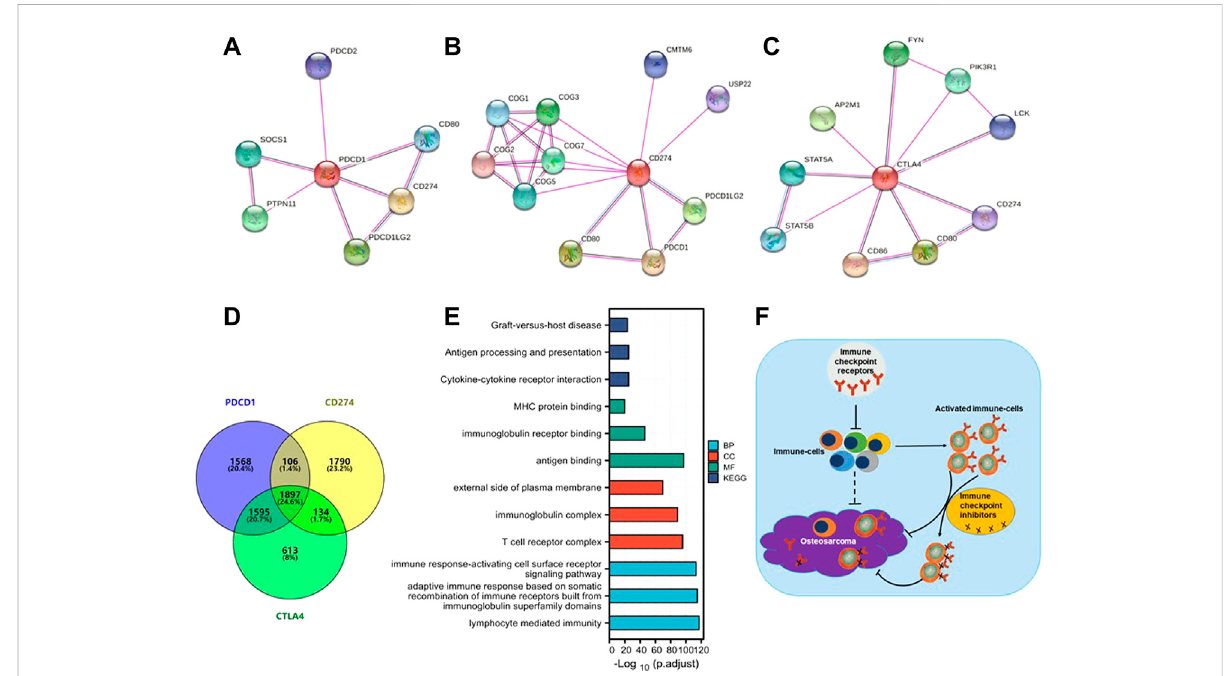
FIGURE 8 PD-1/PD-L1/CTLA-4 relatedgeneenrichmentanalysis. (A,B,C) The top10hubgenesinthePPI(Protein- ProteinInteraction)networkwithhigh con fi dence using STRING tool. Circles represent different genes in the three modules, and interconnecting lines represent interactions between these genes. PD-1 (A) , PD-L1 (B) and CTLA-4 (C) are high-con fi dence hub genes for each other (circle logo). (D) Venn diagram showed that PD-1/ PD-L1/CTLA-4 cross-co-expressed 1897 genes in SARC, accounting for the largest proportion of 24.6%. (E) Based on PD-1/PD-L1/CTLA- 4 cross-co-expressed genes, GO-KEGG pathway enrichment analysis revealed co-expressed pathways. Gene Ontology (GO); Kyoto Encyclopedia of Genes and Genomes (KEGG); biological process (BP); molecular function (MF); cellular component (CC). (F) A Schematic inference model showing immune checkpoint receptors regulation of osteosarcoma. Immune checkpoint receptors inhibit the activation of immune cells;